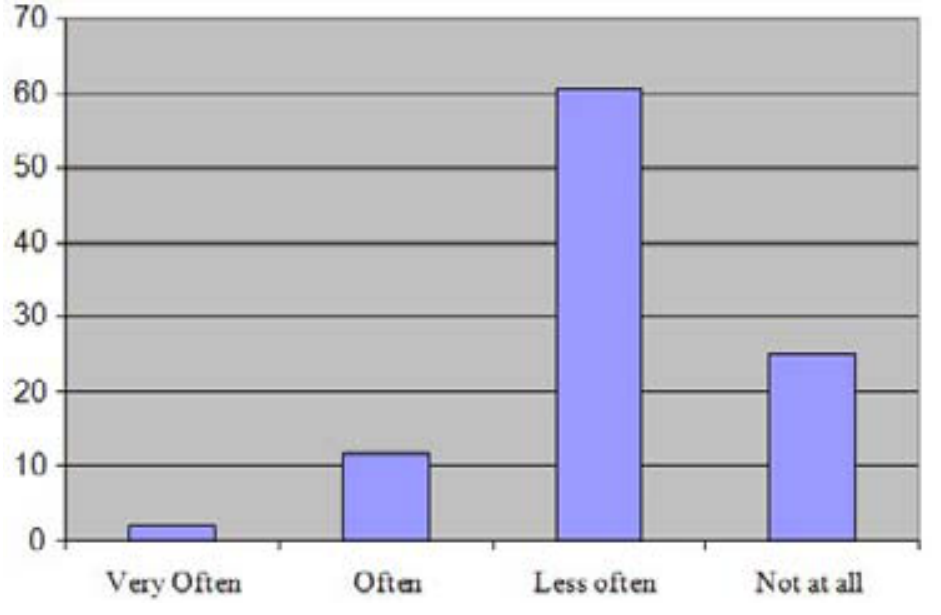
Figure 1 . Student opinion on ODeL evaluation